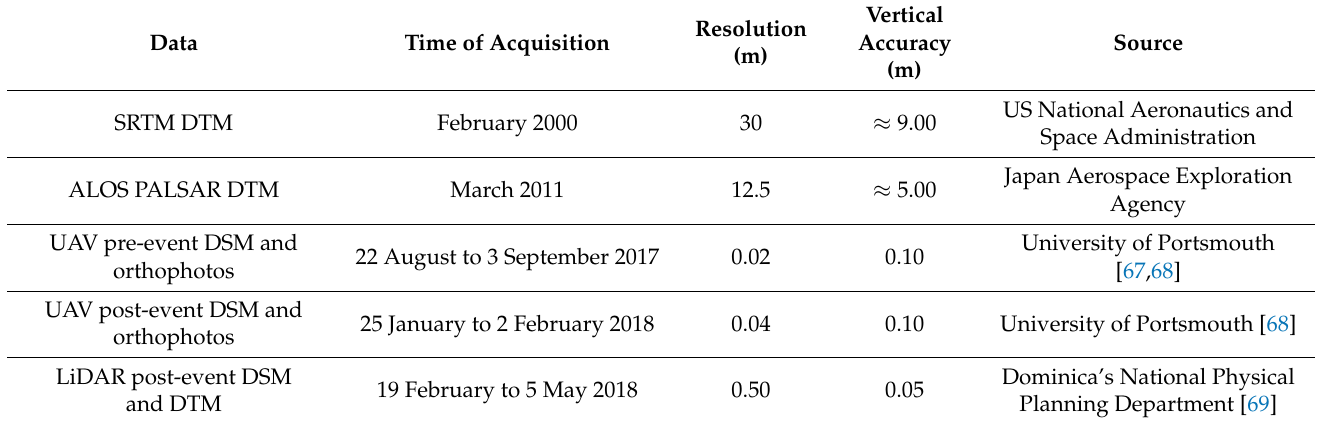
Table 2. Specifications of remote sensing datasets. The hurricane occurred on 18 September